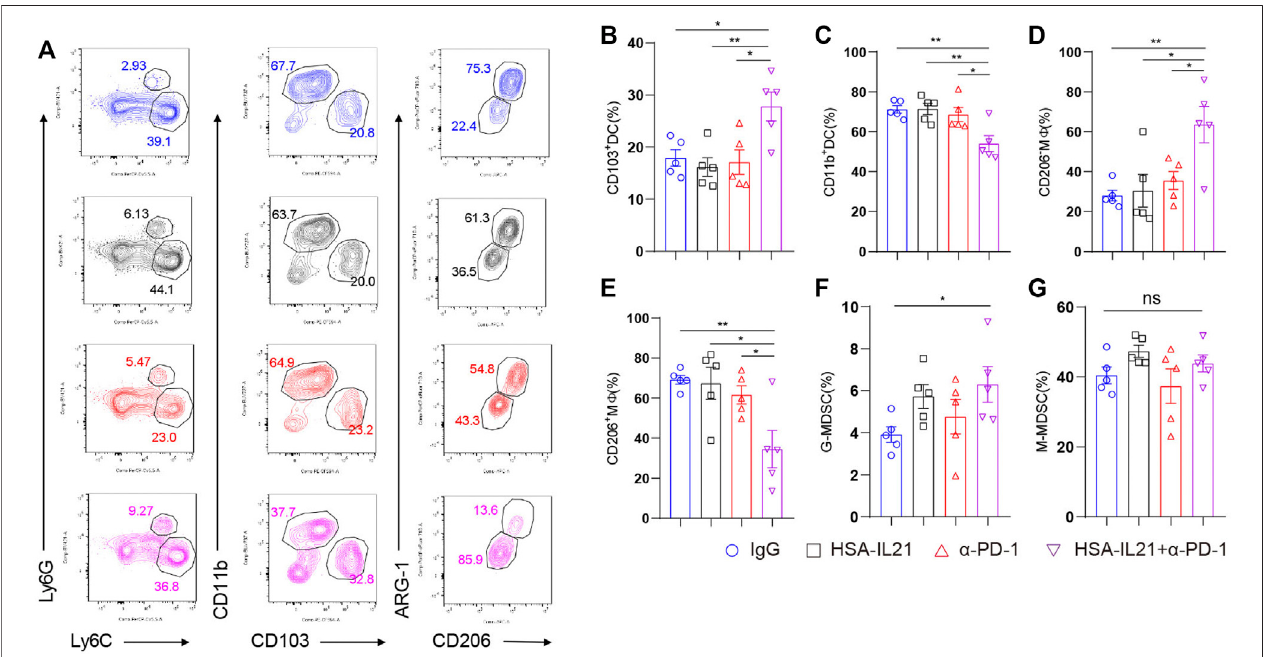
FIGURE 5 | Combination therapy induced myeloid cells that promote the CD8 + T cell-mediated immune response against cancer. (A – G) MC38 tumor cells (1 × 10 6 )wereinjectedintradermallytoB6mice,9daysaftertumorinoculation,MC38tumor-bearingmiceweretreatedwithIgG,HSA-IL21, α -PD-1,HSA-IL21/ α -PD-1,96h later,tumorswereresectedandanalyzedby fl owcytometry.Representative fl owplotsshowingthepercentageofmyeloidpopulations. (B – G) Quantitativepercentageof tumor in fi ltrating dendritic cells, macrophage, MDSC. Data were presented as mean ± SEM, n (cid:2) 5, *p < 0.05, ** p < 0.01, *** p < 0.001, **** p < 0.0001, one-way ANOVA test was